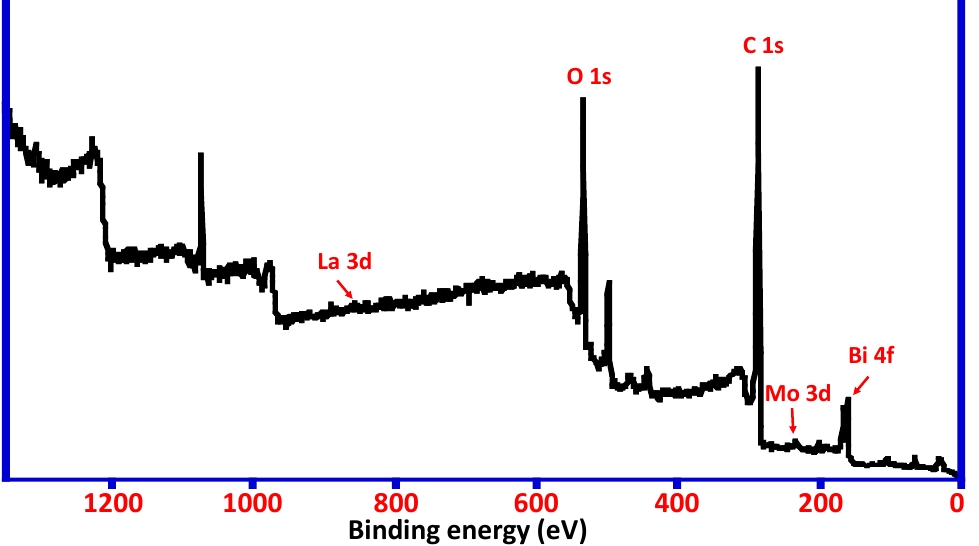
Figure 7. XPS spectra of the 4% LBM/GO composite.